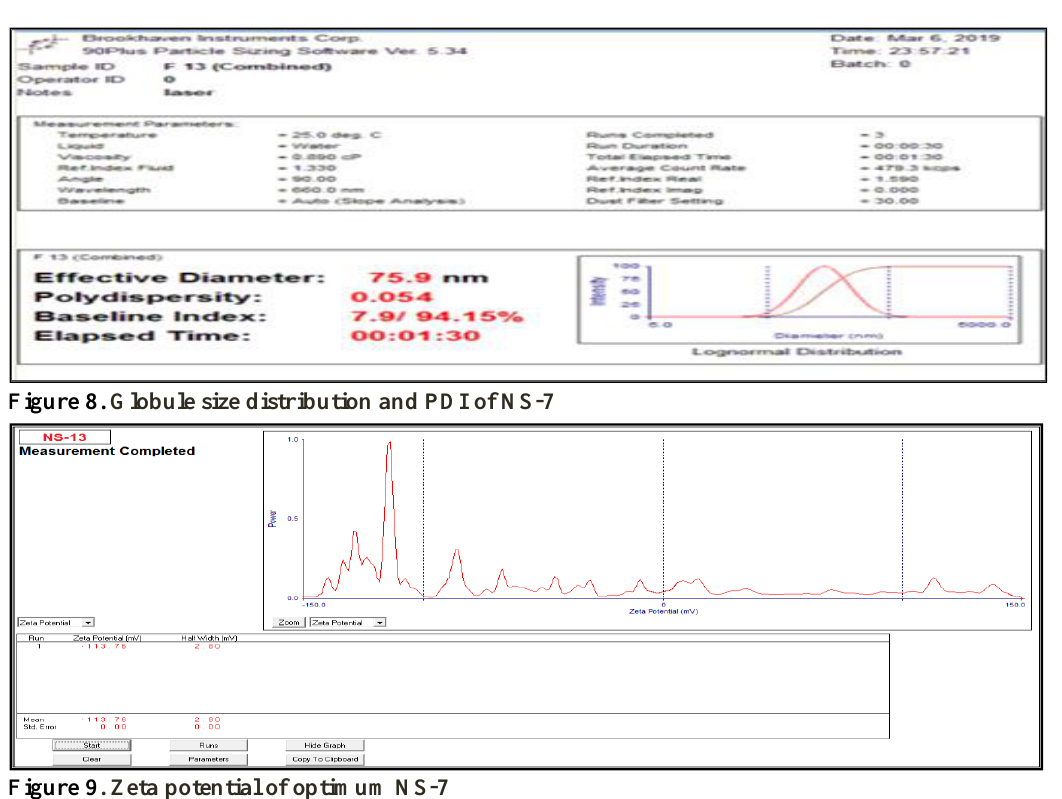
Figure 9. Zeta potential of optimum NS-7 Morphology examination of optimum LZL NS-7 nanoemulsion formula